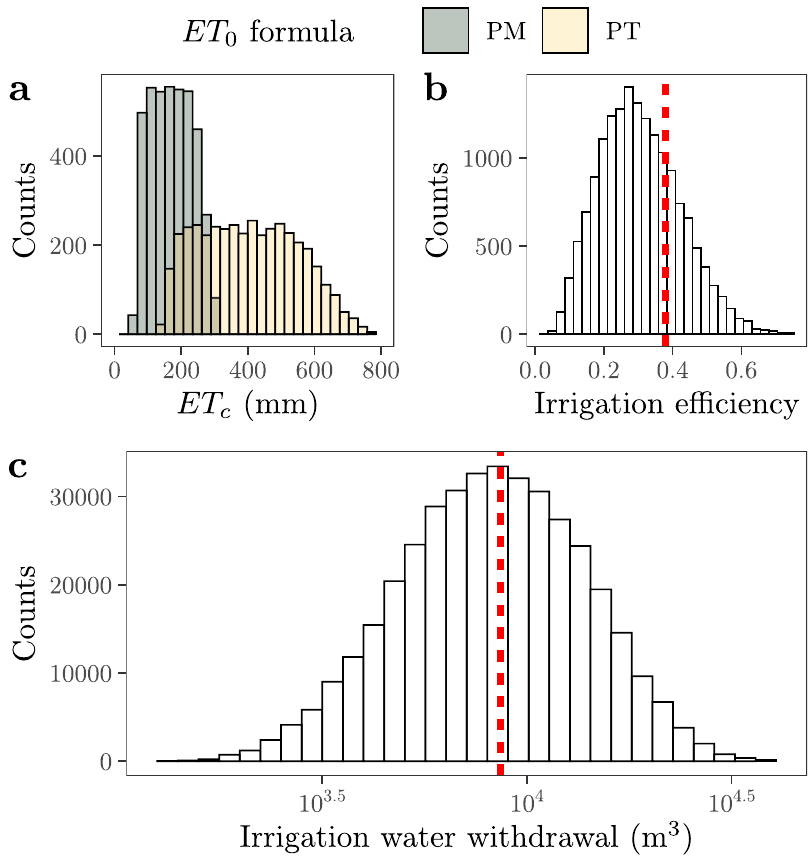
Fig. 1 Examples of the ambiguities embedded in the calculation of global irrigation water withdrawals 4 . a Uncertainties in the estimation of the crop evapotranspiration (ET c ). PM and PT stand for the Penman – Monteith and the Priestley – Taylor equation, respectively. Data is retrieved from Nichols et al. 11 . We describe the uncertainty in k c with the values reported for salt cedar for May 4 . b Distribution of the irrigation ef fi ciency of China after propagating uncertainties. The red, dashed line marks the ef fi ciency value used by some large-scale models 12 . c Distribution of the water withdrawn to irrigate wheat in a speci fi c grid cell of the Uvalde County, TX, USA (lon = − 99.7083, lat = 29.4583), January 6 – 7, 2007. All uncertainties in the calculation of IWW are considered 4 . The red, vertical line is the estimate produced when the uncertain parameters used in the calculation of IWW are characterized with point estimates (e.g., mean